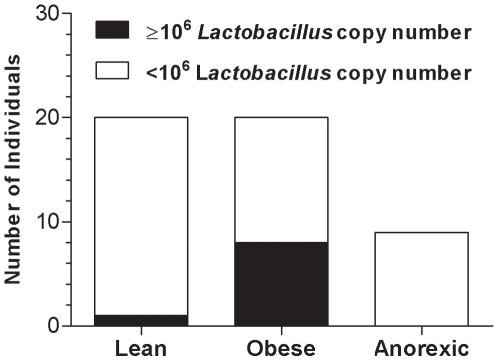
Distribution of high Lactobacillus concentrations.The number of individuals having a high Lactobacillus concentration was 1 out of 20, 8 out of 20, and 0 out of 9 for the lean, obese, and anorexic groups, respectively.